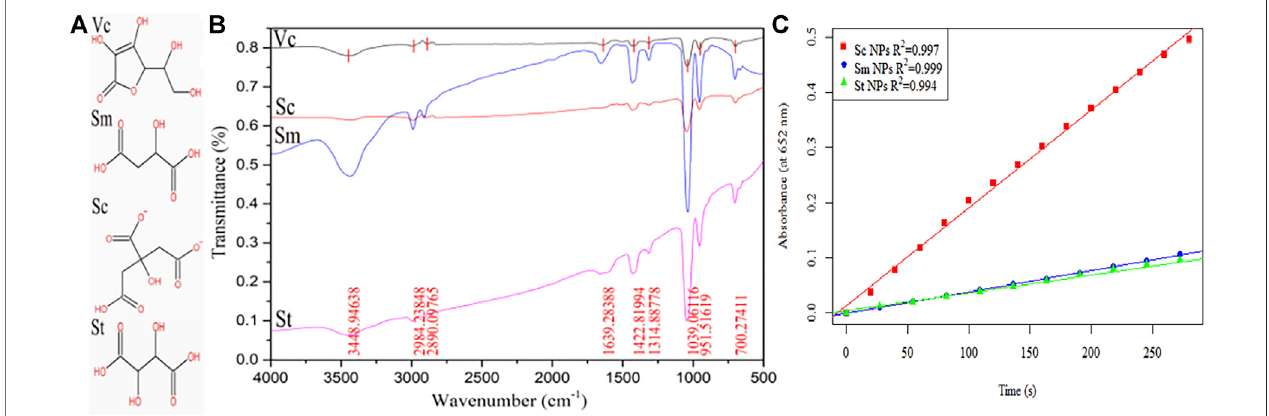
FIGURE 8 | (A) The molecular structure of Vc, Sc, Sm and St and (B) the infrared spectra of the prepared colloidal gold nanoparticles after reduction. (C) Part of Figure 5 .